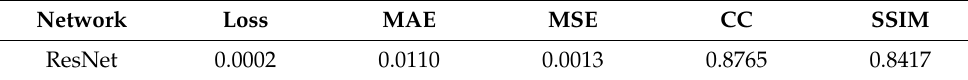
Table 1. Different metrics for ResNet on the test dataset. Network Loss MAE